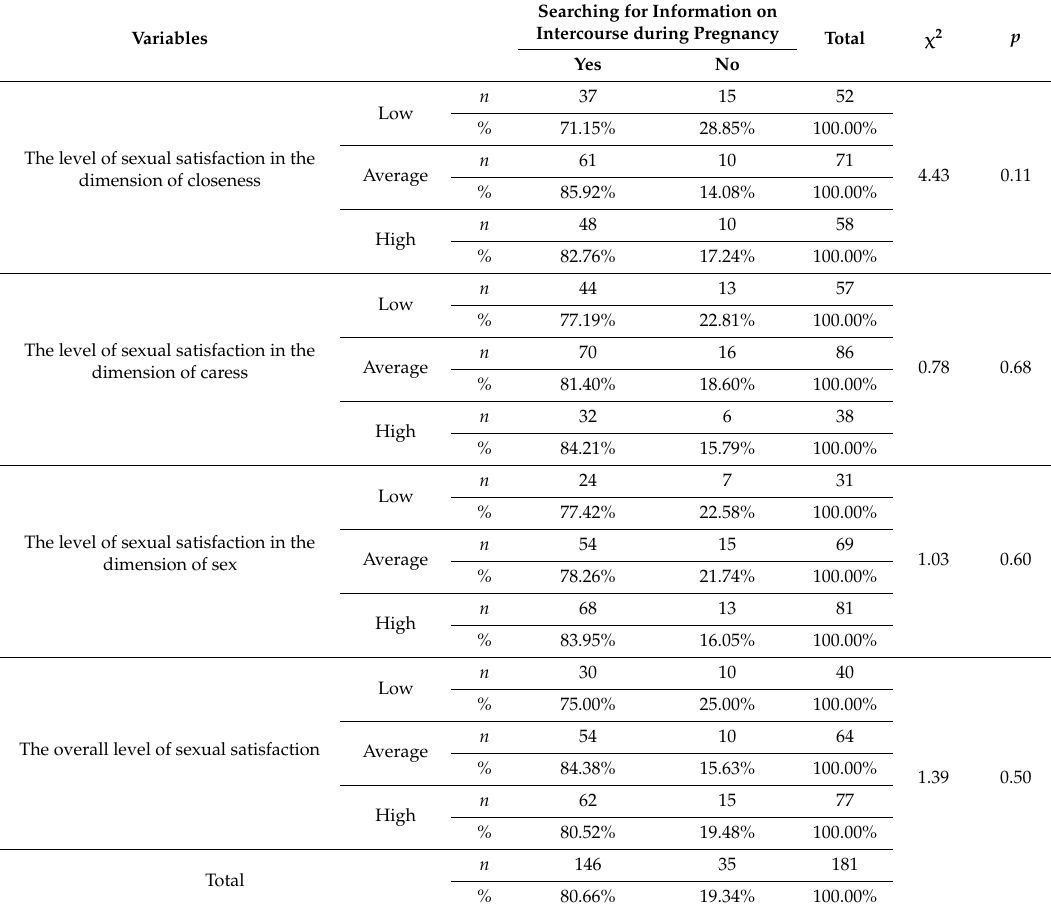
Table 14. Relationship between the level of sexual satisfaction and searching for information on intercourse during